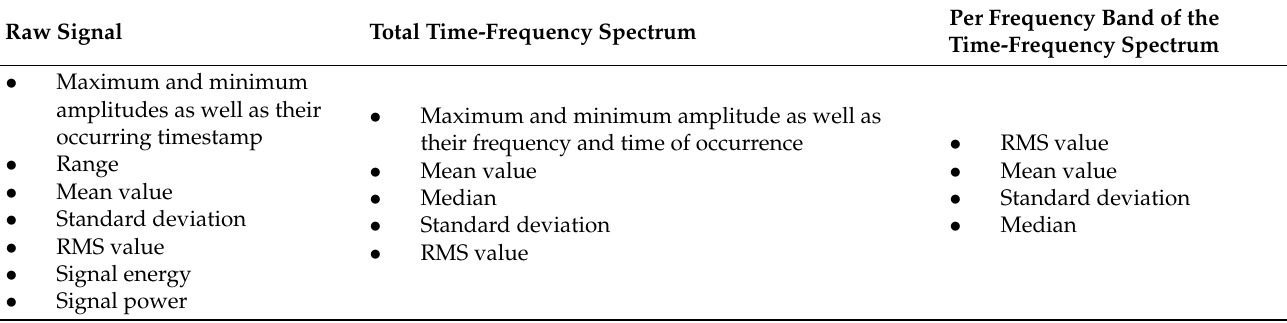
Table 3. Types of extracted features from the raw signal and time-frequency spectra. Raw Signal Total Time-Frequency Spectrum